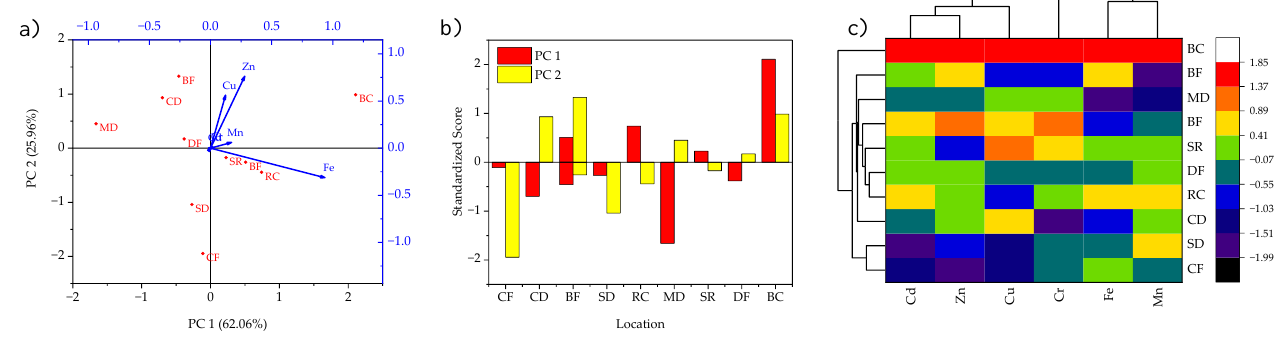
Figure 2. ( a ) Axial biplot; ( b ) PCA-standardized scores; and ( c ) HCA dendrogram with heatmap for heavy metal contents in P. ostreatus collected from different locations of Rajaji National Park, Haridwar, India.